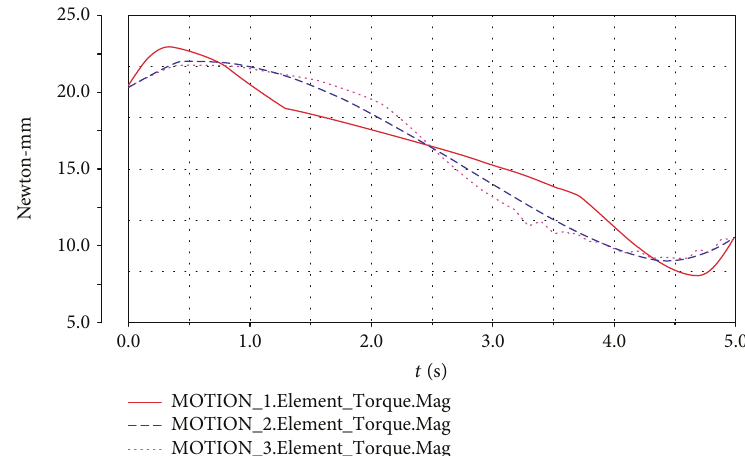
Figure 15: Torque for the upper platform moving upward. MOTION_1: modi fi ed constant velocity function; MOTION_2: modi fi ed sine function, MOTION_3: modi fi ed trapezoidal function.